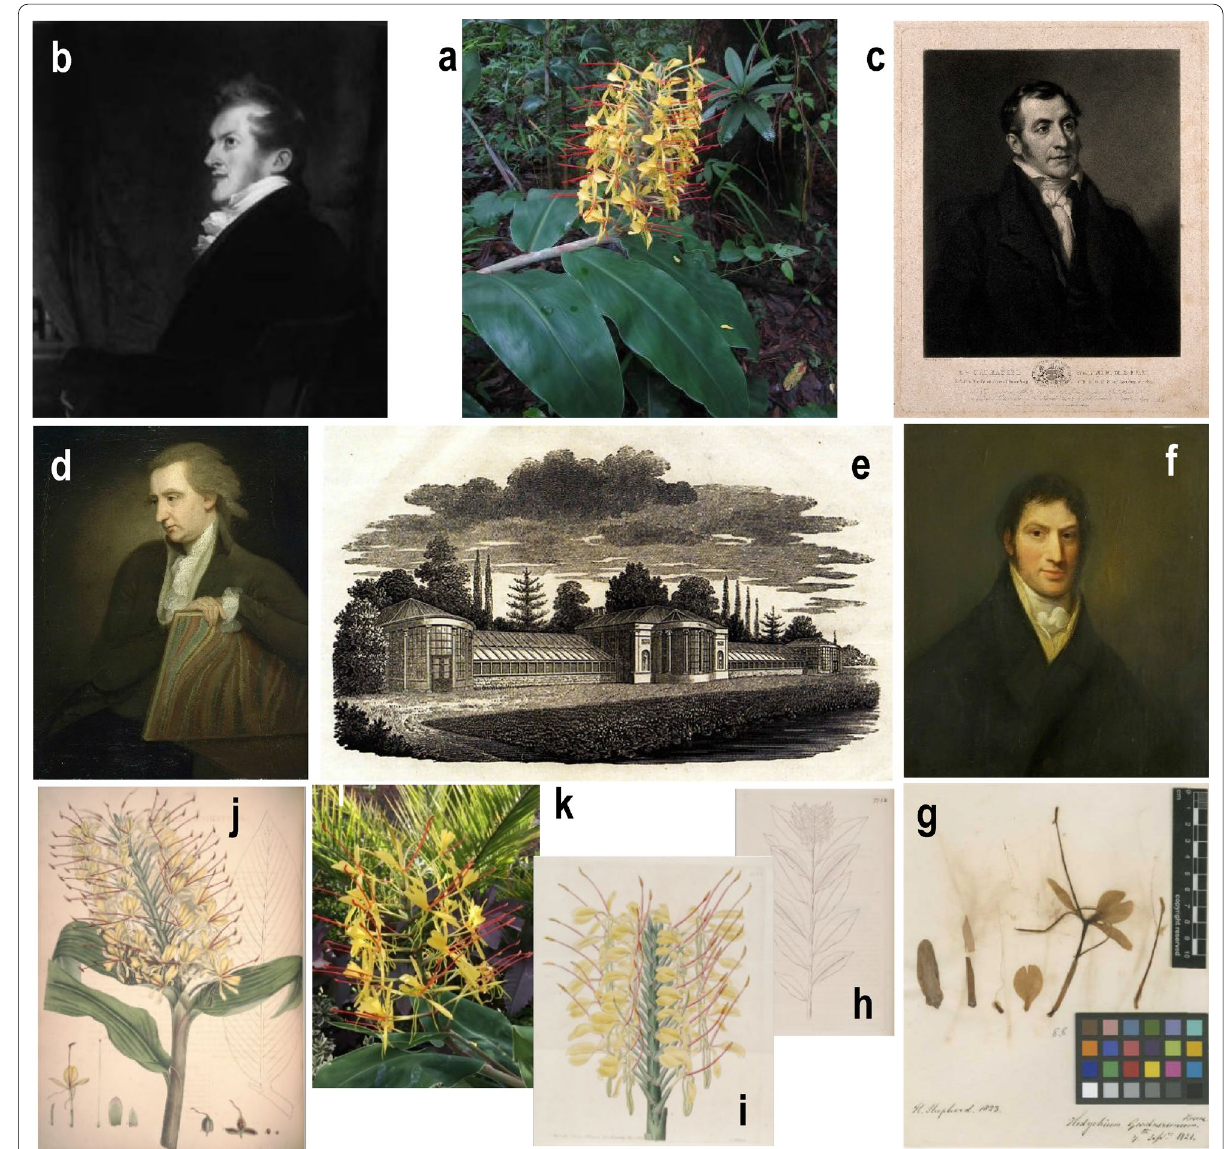
Fig. 2 a Flowering plant of Hedychium gardnerianum in its native habitat at Nepal (Lalitpur district of Kathmandu Valley) (Photographer B. Adhikari) (Flora of Nepal 2021). b Edward Gardner (Resident to the Court of Nepal from 1816 to 1829) (Bilder aus Nepal 2021; Fraser-Jenkins 2006); c Nathaniel Wallich in 1833 (Director of the Calcutta Botanical Garden from 1817 to 1846) (Welcome Collection 2021; Das Gupta 2011); d William Roscoe (Co-founder of the Liverpool Botanic Garden in 1802) (Walker Art Gallery 2021a; Roscoe 1833); e Conservatory in 1808 at Liverpool Botanical Garden in Mount Pleasant (1802–1831) (Kaye 1820; Law 2007). f John Shepherd (curator of Liverpool Botanic Garden at Mount Pleasant from 1802 to 1831) (Greenwood et al. 2018; Walker Art Gallery 2021b); g First dried specimen made by Henry Shepherd in the second year of plant blooming